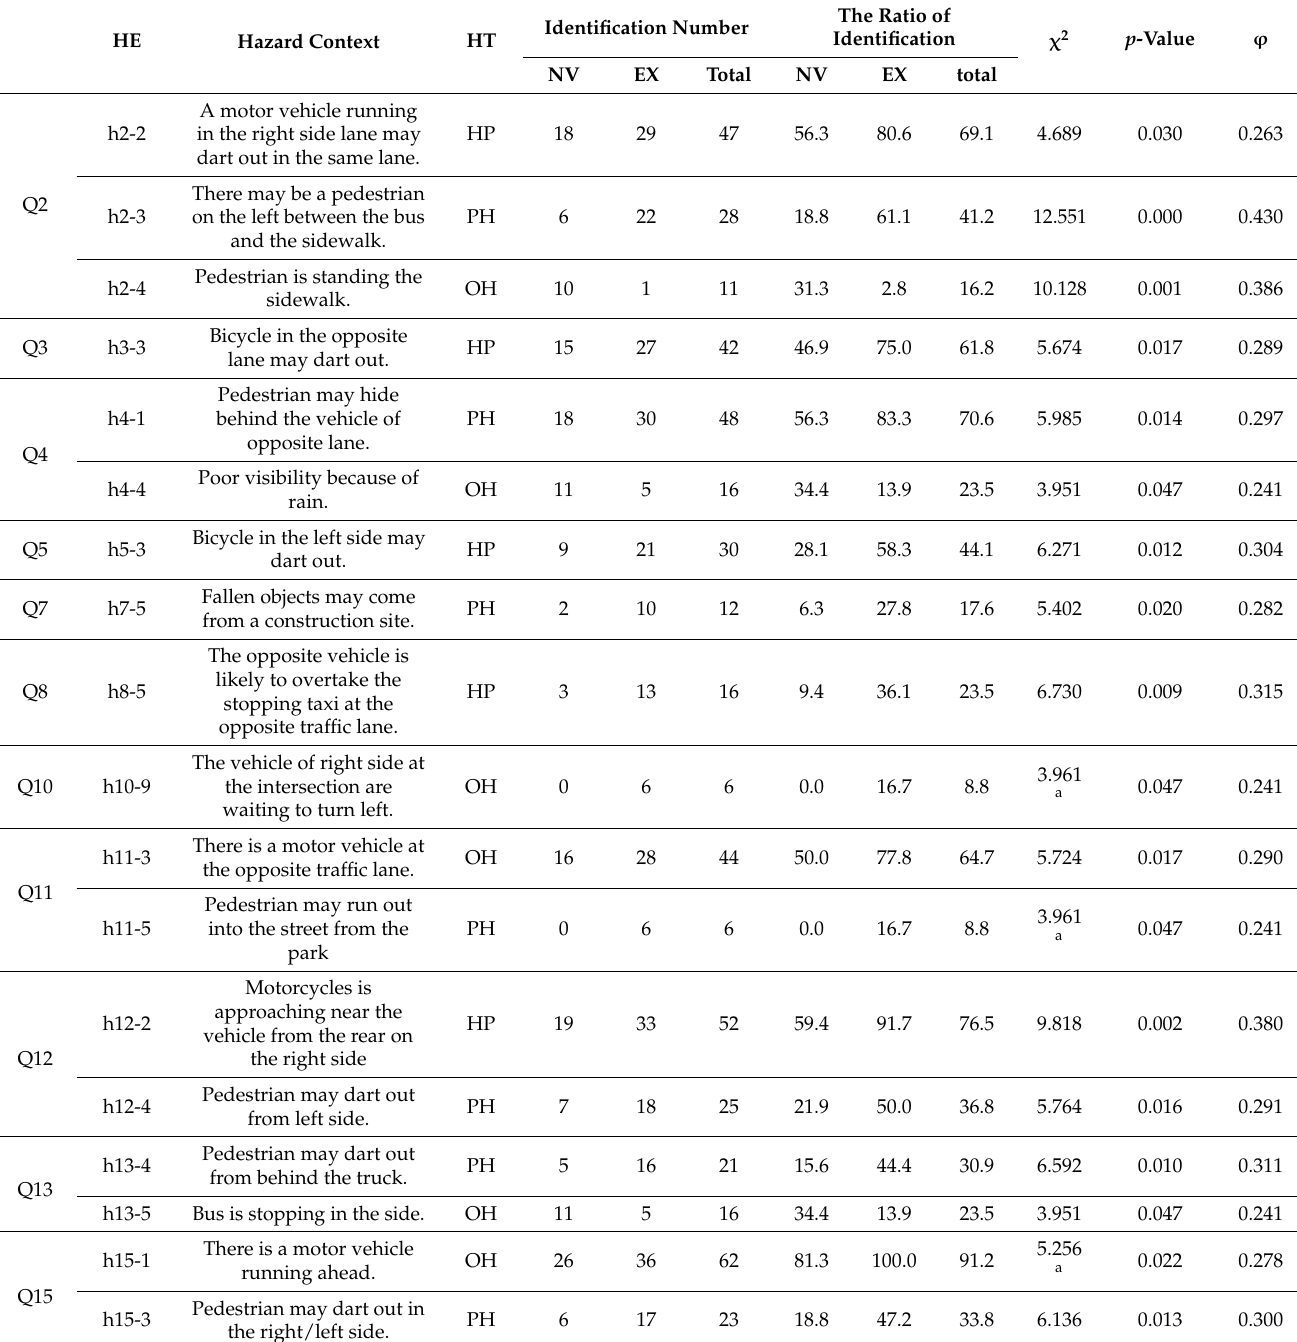
Table 4. Hazard contexts which had significant differences by a chi-square